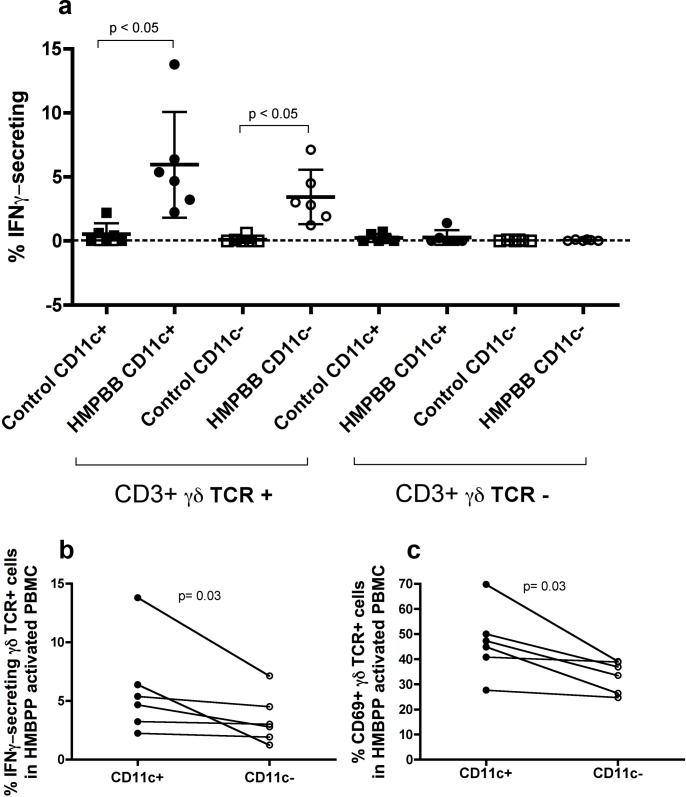
IFN-γ-secreting γδ T cells in PBMC from healthy women after HMBPP activation.(a) Comparison of the frequency of γδTCR+ CD11c+/- and γδTCR- CD11c+/- T cells that secrete IFNγ in PBMC from the same individual (n = 6) after 20 hours of (E)-4-hydroxy-3-methyl-but-2-enyl pyrophosphate (HMBPP) activation. Gating strategy consisted on the following consecutive gates: lymphocytes, singlets, CD3+ T cells, γδTCR+/-, CD11c+/- and IFNγ/CD69+ expression. Each bar represents the mean ± SD of control (squares) and HMBPP-stimulated PBMC (circles) samples. Data were analyzed using the non-parametric Friedman test for repeated measures, with Dunn’s multiple comparisons post-hoc test. Graphs below show the comparison in the frequency of (b) IFN-γ-secreting γδ T cells and (c) CD69 expression in γδ T cells based on CD11c expression in HMBPP-activated PBMC from the same individual (n = 6). Data were analyzed using Wilcoxon matched-paired signed-ranked test.